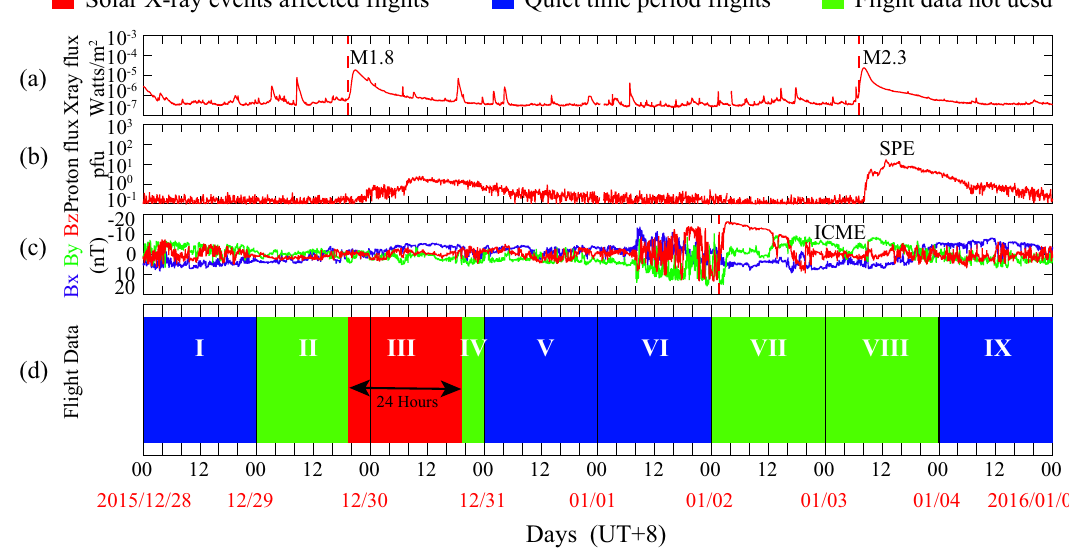
Figure 1. The definition of solar X-ray events affected flights (red) and quiet time periods flights (blue). ( a ) Solar soft X-ray flux from the GOES satellite. ( b ) Solar magnetic component flux from the ACE satellite. ( c ) Proton flux from the GOES satellite. ( d ) Flight data based on scheduled departure